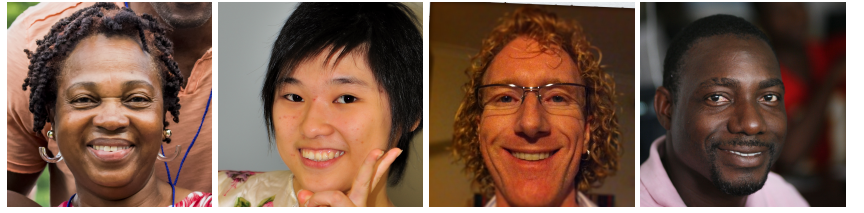
Figure 1. Some digital images considered from the work of Karras et al. [41] to build our dataset of printed